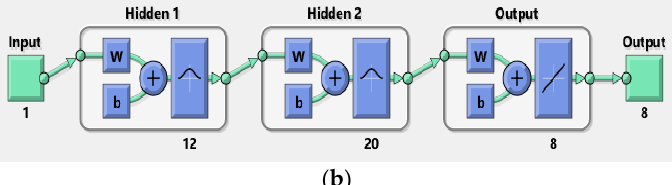
Figure 3. A neural network training performance, an input, couple hidden and output layers for solving the nonlinear dynamics of the MTS. ( a ) A neural network training performance, ( b ) An input, couple hidden and output layers to solve the MTS.